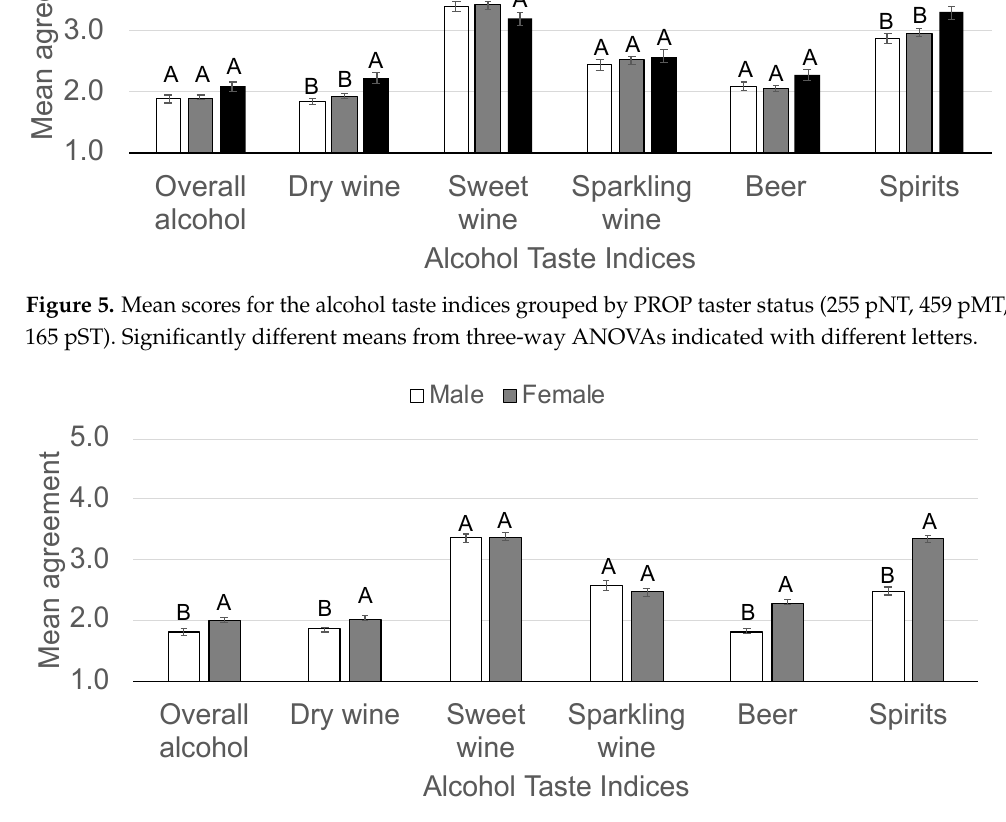
Figure 6. Mean scores for the alcohol taste indices grouped by sex (351 male, 528 female). Significantly different means from three-way ANOVAs indicated with different letters.